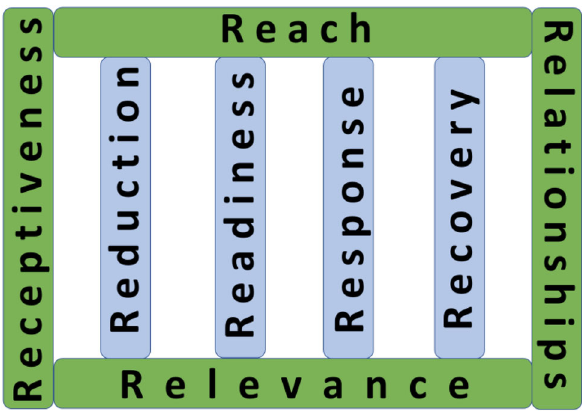
Fig. 1 Embedding the pillars of the original 4Rs of disaster risk reduction into the frame of the new 4Rs of disaster risk